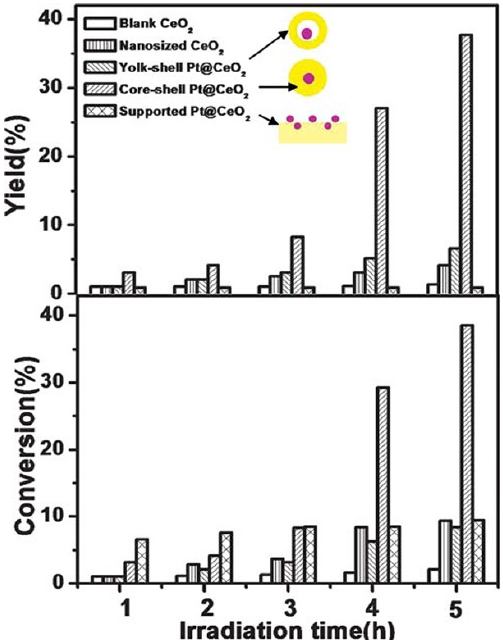
Figure 9. Results of photocatalytic selective oxidation of benzyl alcohol to benzyl aldehyde over the core-shell Pt@CeO 2 , yolk-shell Pt@CeO 2 , supported Pt/CeO 2 , CeO 2 nanoparticles and blank CeO 2 . Reproduced from [110], with copyright permission from The Royal Society of Chemistry, 2011.